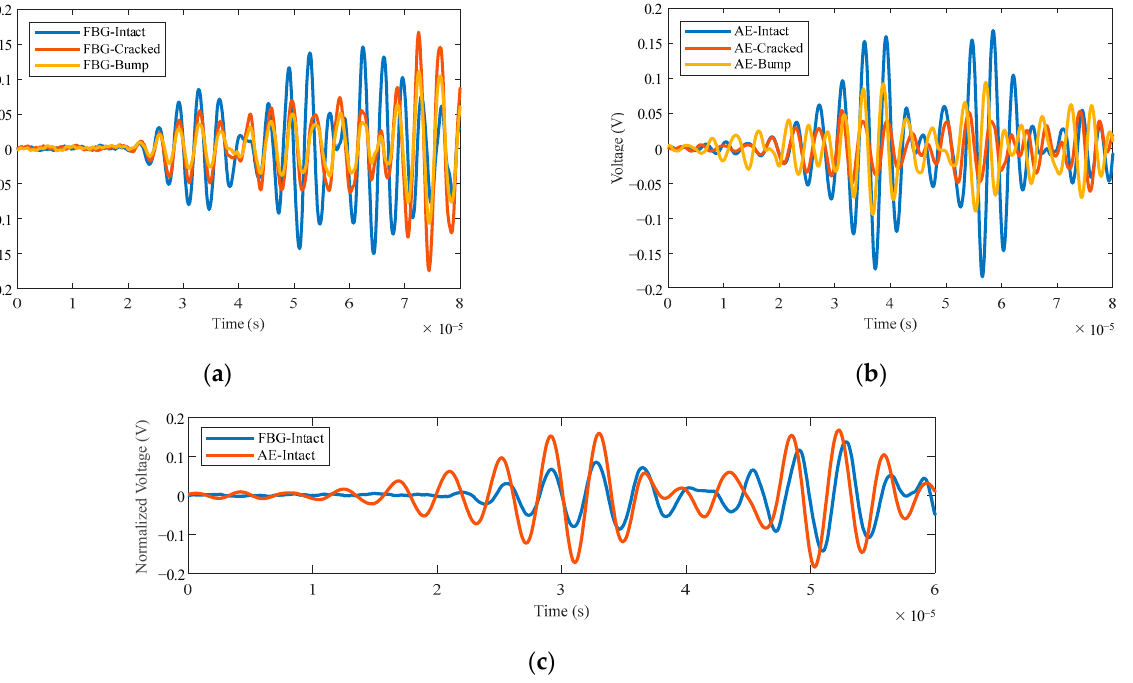
Figure 7. The time-domain signals under different conditions acquired by: ( a ) FBG sensors and ( b ) AE sensors; ( c ) Waveform comparison between FBG and AE signals under the intact condition. The spectrums of both the FBG and AE signals are obtained through Fast Fourier Transform (FFT). Only slightly visible variations have been observed in the spectrums obtained from the experiments (Figure 9). The central frequency is approximately 250 kHz, which indicates that the UGW receiving quality is eligible. Due to the presence of the damage, the oscillation amplitude of the spectral amplitude shows a visible decline. How- ever, the artificial crack and the blu-tack adhesives have dispersed the central frequencies, resulting in wider bandwidths of frequencies. Additionally, the noise level of FBG data